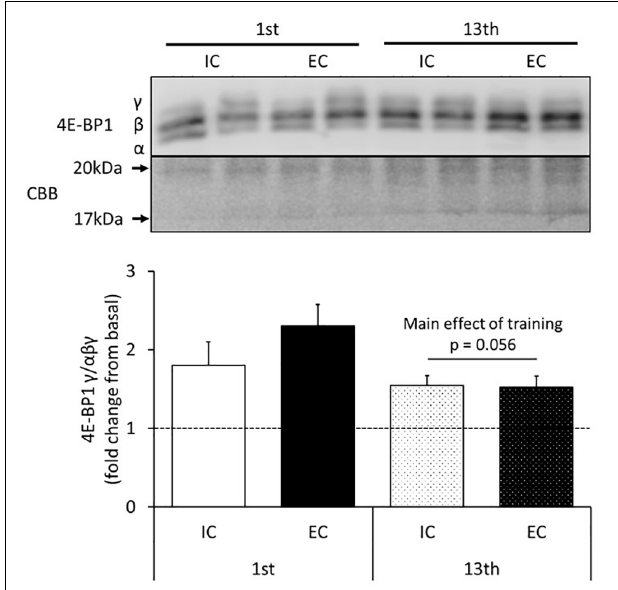
FIGURE 3 | The expression of the γ isoform of 4E-BP1 after the 1st and 13th bouts of exercise. Values are means ±